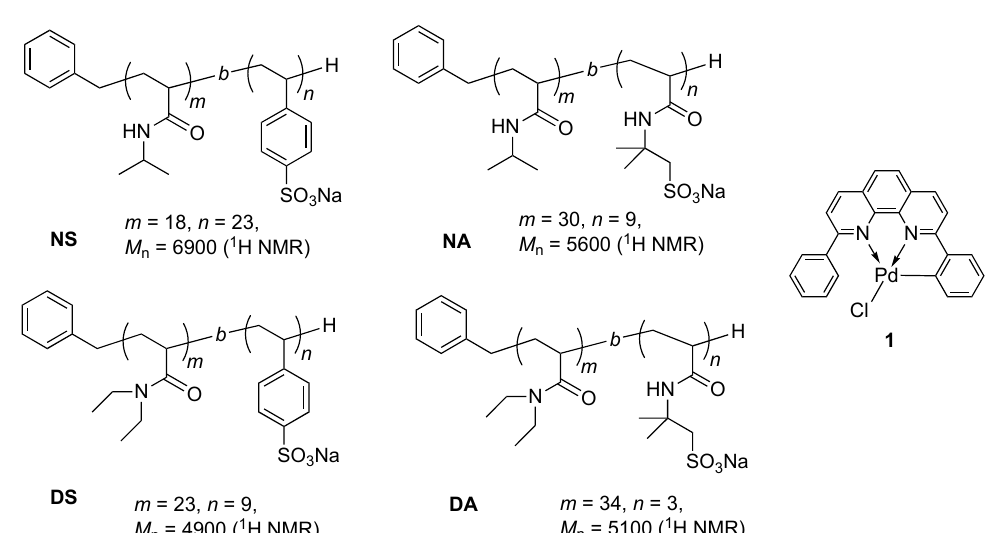
Figure 2. Thermoresponsive diblock copolymers (with typical m and n ) and palladium complex 1 .